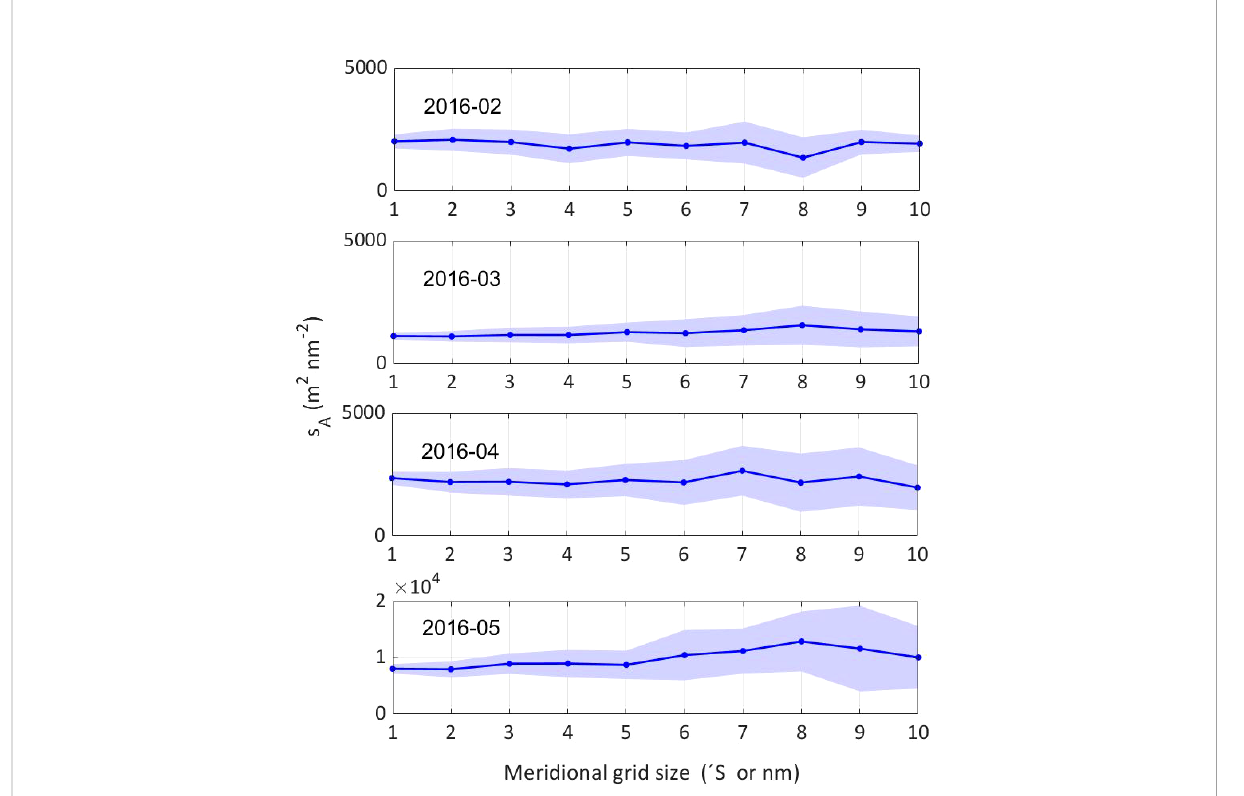
FIGURE 5 The estimations of nautical area scattering coef fi cient (NASC) in the hotspot with 10 gridding scenarios in February – May 2016. Error bars represent 95% con fi dence intervals of